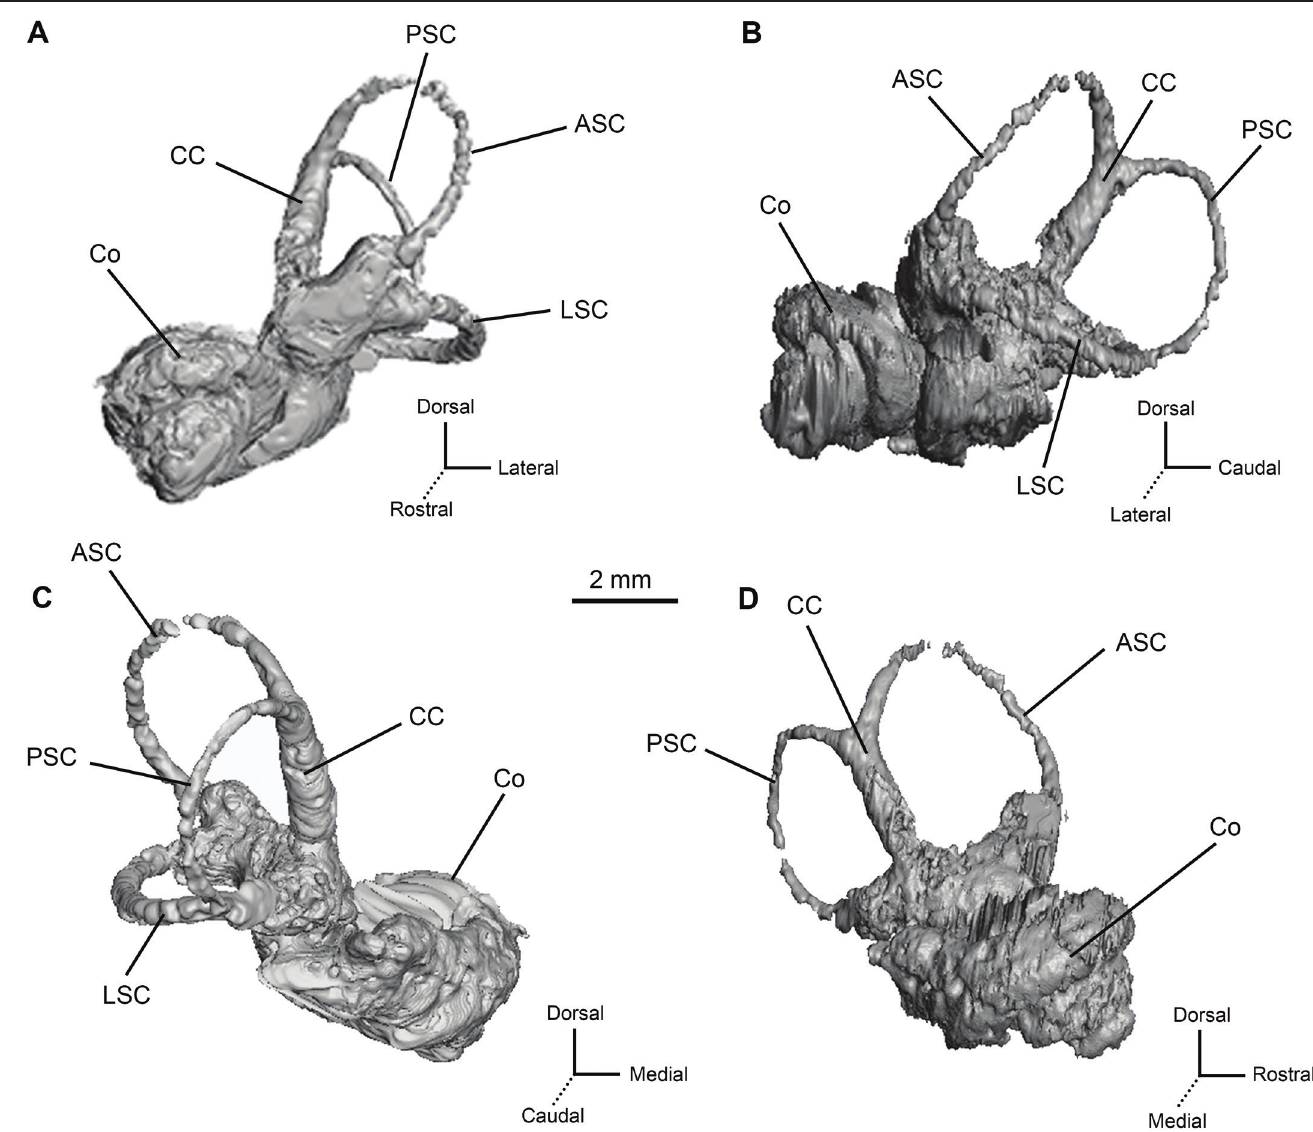
Figure 5. Four views of the left bony labyrinth of SDSNH 47878. A, rostral view; B, lateral view; C, caudal view; D, medial view. Abbreviations: ASC, anterior semicircular canal; CC, common crus; Co, cochlea; LSC, lateral semicircular canal; PSC, posterior semicircular